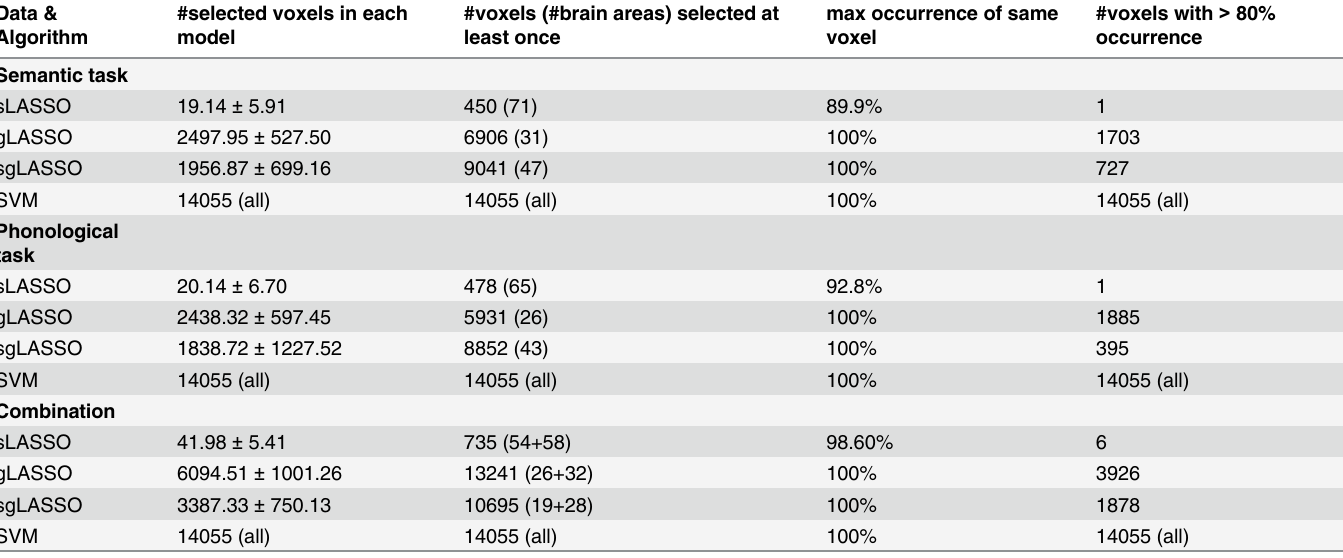
Table 3. Feature Selection (mean ± std over 100 10-fold cross-validations, i.e. 1000 classification